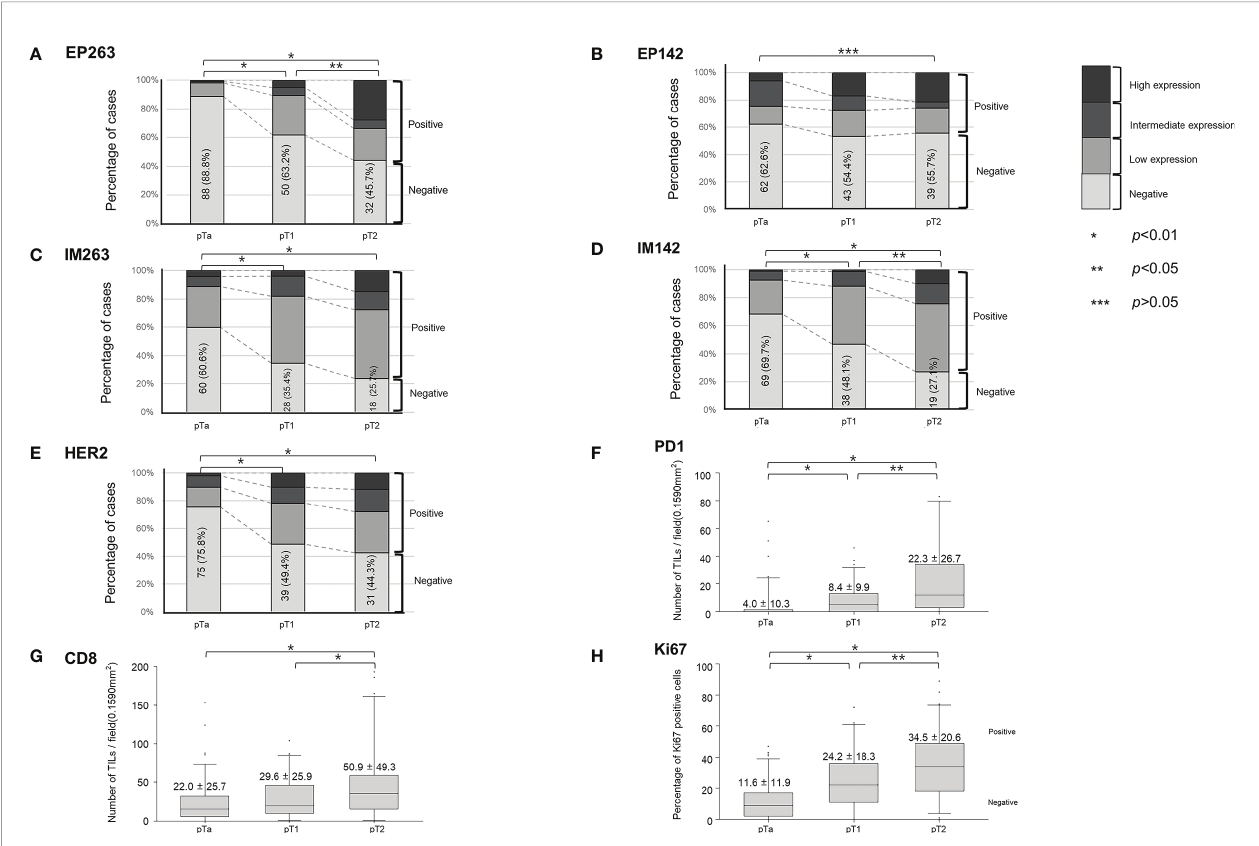
FIGURE 3 | Baseline expression of tumor microenvironment markers according to T-stage. The percent of positive cases are shown for (A) EP263, (B) EP142, (C) IM263, (D) IM142, and (E) HER2 according to T-stage. The expression levels of (F) PD1, (G) CD8, and (H) Ki67 according to T-stage are also shown. TILs, tumor-in fi ltrating lymphocytes; HER2, human epidermal growth factor receptor-2; PD1, programmed cell death protein